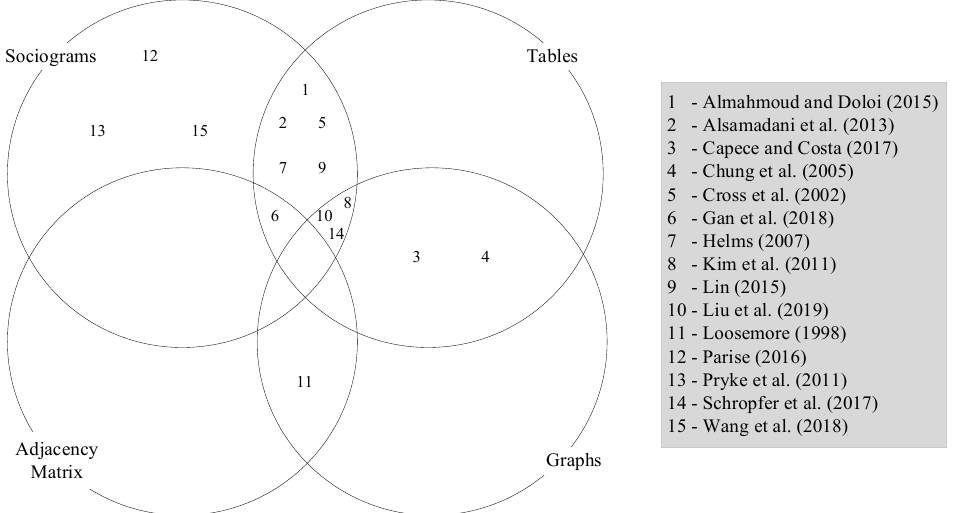
Figure 3. Presentation outputs produced in studies related to using SNA in KM.